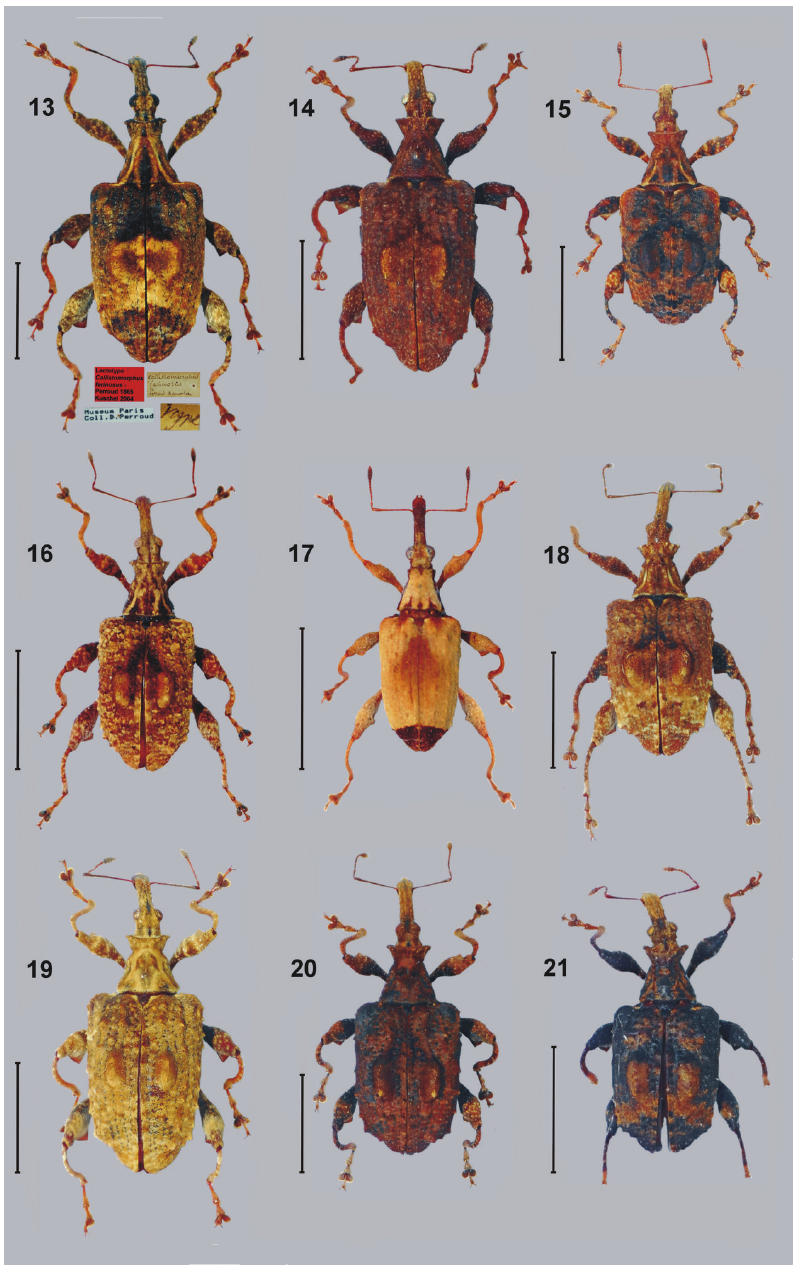
Figures 13–21. Dorsal habitus colour photographs of New Caledonian species from the genus Callisto- morphus : 13 C. farinosus Perr., lectotype, female with original labels 14 C. fundatus sp. n., male, holotype 15 C. gibbus sp. n., holotype, male 16 C. malleus sp. n., paratype, female 17 C. minimus sp. n., holotype, female 18 C. rutai sp. n., holotype, male 19 C. szoltysi sp. n., holotype, female 20 C. torosus sp. n., para- type, female 21 C. turbidus sp. n., holotype, male. Scale bar = 5